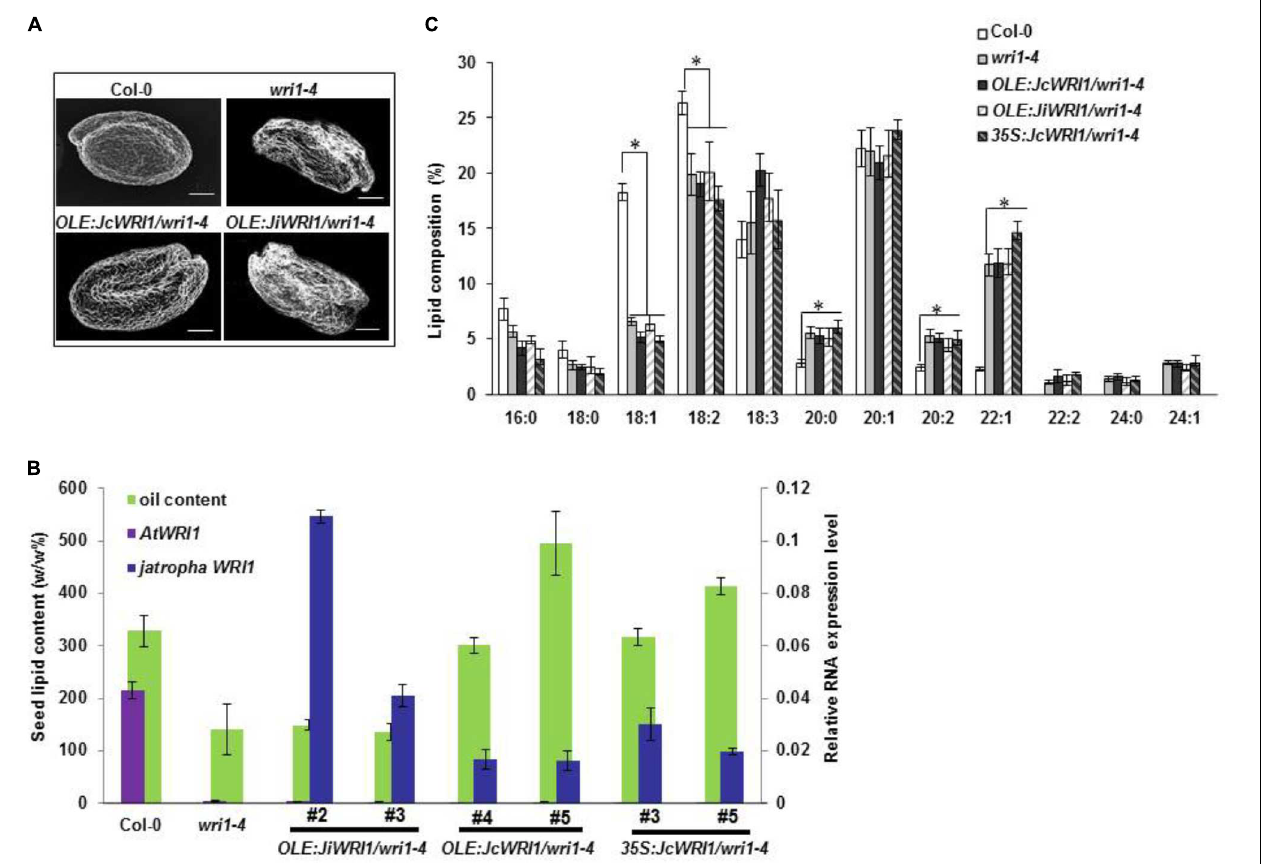
FIGURE 5 | JcWRI1 but not JiWRI1 complements the Arabidopsis thaliana wri1-4 mutant. (A) Images of mature seeds of the wild-type (Columbia-0 [Col-0] ecotype), mutant ( wri1-4 ), complemented mutant ( OLE:JcWRI1/wri1-4 ), and non-complemented mutant ( OLE:JiWRI1 / wri1-4 ). Size bar: 100 µ m. (B) Seed lipid contents and WRI1 gene expression levels of Col-0, wri1-4 , 2 independent wri1-4 lines complemented with JiWRI1 transcribed from the seed specific oil palm ( Elaeis guineensis ) Oleosin promoter ( OLE:JiWRI1/wri1-4 ), and four independent wri1-4 lines complemented with JcWRI1 transcribed from either the seed specific Oleosin promoter ( OLE:JcWRI1/wri1-4 ) or a CaMV 35S promoter. For each transgenic line, five plants were grown. Twenty seeds were harvested from each plant and pooled. Error bars correspond to the SD calculated from three biological replicates per pool of 100 seeds. Expression levels of both AtWRI1 and Jatropha WRI1 ( JcWRI1 or JiWRI1 ) in complementary lines were measured by qRT-PCR using RNAs isolated from mature seeds. The A. thaliana actin2 and the Jatropha Ubiquitin transcripts served as an internal control for all RNA samples. Error bars correspond to the SD calculated from seeds samples of three plants from each line. (C) Lipid composition in Arabidopsis seeds of Col-0, wri1-4 , two independent wri1-4 lines complemented with JiWRI1 transcribed from the seed specific oil palm ( Elaeis guineensis ) Oleosin promoter ( OLE:JiWRI1/wri1-4 ), and four independent wri1-4 lines complemented with JcWRI1 transcribed from either the seed specific Oleosin promoter ( OLE:JcWRI1/wri1-4 ) or a CaMV 35S promoter. Error bars correspond to the SD calculated from three biological replicates per pool of 100 seeds. Values are mean ± SD ( n = 3) with statistical analysis by Student’s t -test ( ∗ indicates p <